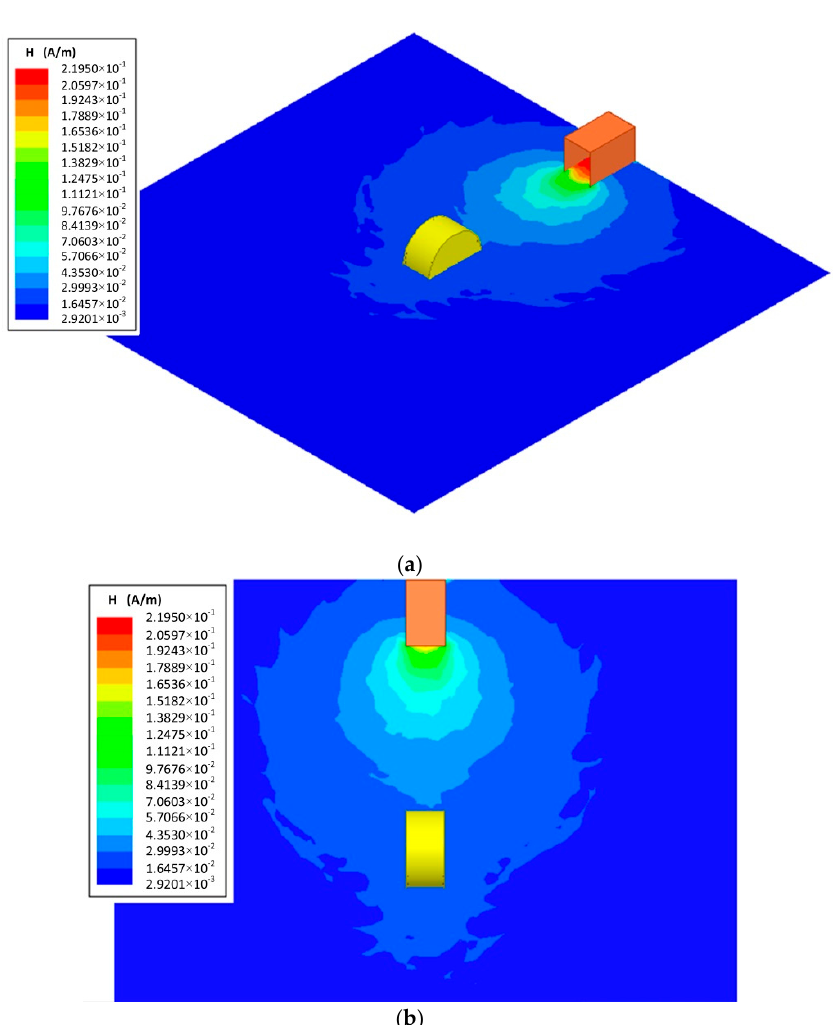
Figure 7. Simulation result of distribution of microwave magnetic field strength when glass cell was inserted. ( a ) Three-dimensional diagram of magnetic field distribution. ( b ) Two-dimensional diagram of magnetic field distribution. The yellow cylinder on the distribution map represents the glass cell. The size of the observation plane was 160 mm × 160 mm. A waveguide was placed at the upside. Electromagnetic waves were radiated to the down at 9.19 GHz. The dimensions of the open-ended waveguide were 22.86 mm × 10.16 mm × 17 mm. We set the diameter of the column basal plane of glass cell to 20 mm, its height to 10 mm, and its thickness to 0.5 mm. The measurement distance was 52 mm. As shown in Figure 5c, observation plane of the distribution of microwave magnetic field strength was in the x-y plane (as the Figure 5c shows).